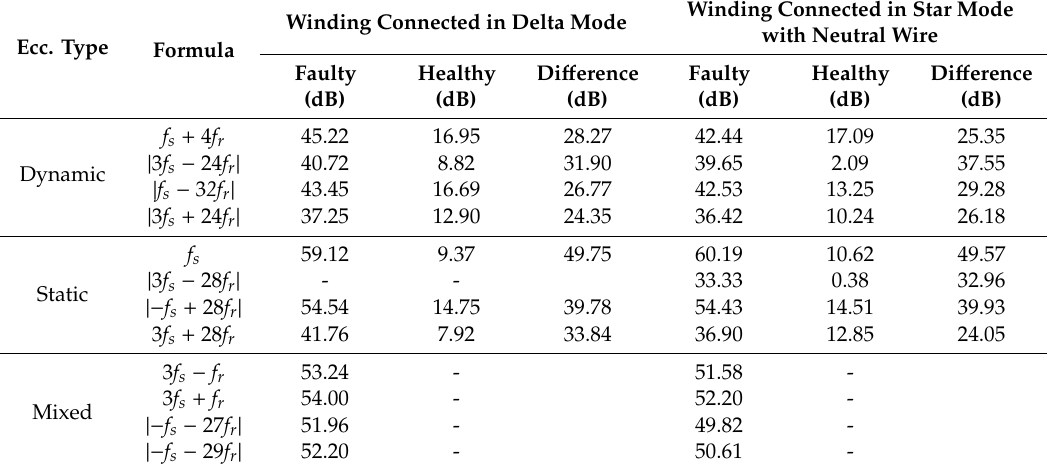
Table 3. Results of harmonic amplitude measurements of characteristic frequencies for a given type of eccentricity, obtained from finite element analysis of a motor with delta and wye connections with a neutral wire stator winding configuration.